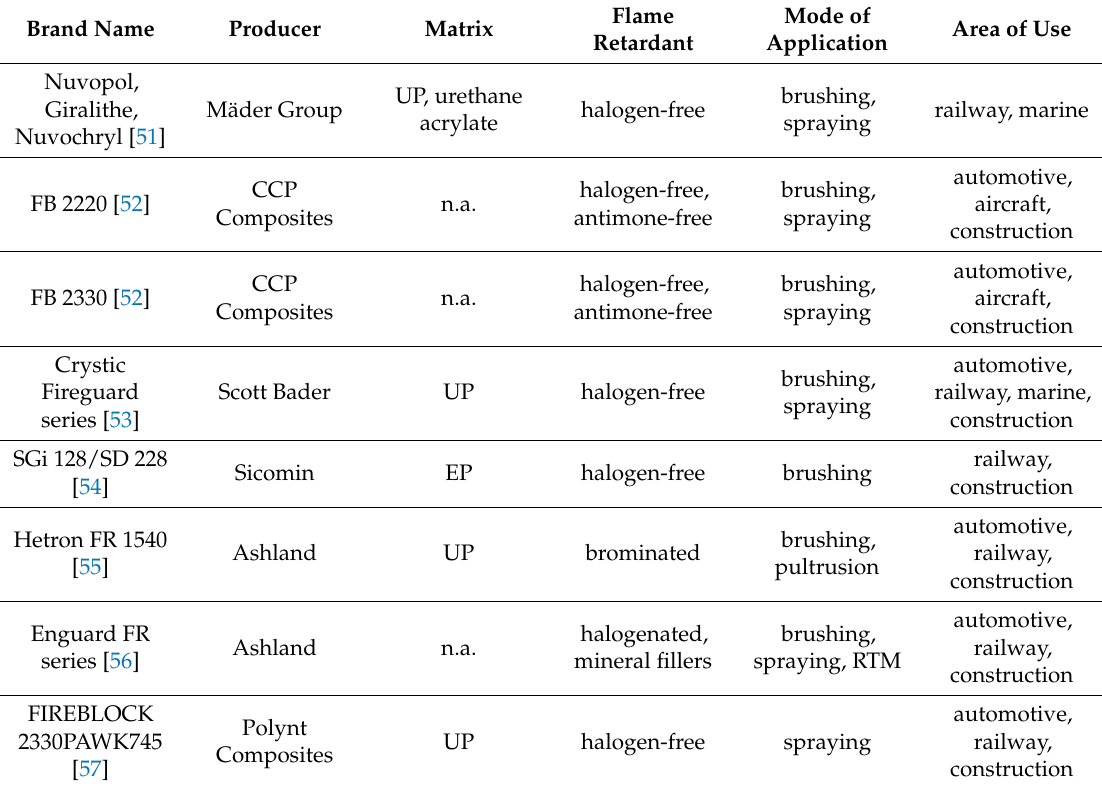
Table 2. Commercially available flame retardant gelcoat systems and their